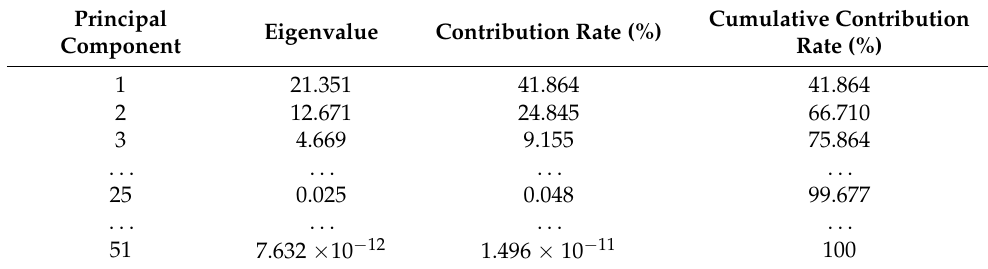
Table 7. Eigenvalues, variance contribution rates, and cumulative contribution rates of each principal component.